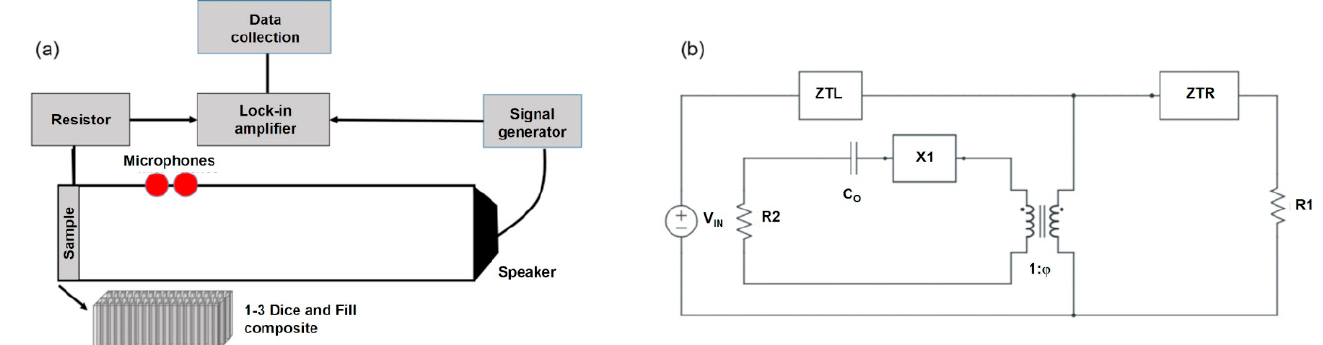
Figure 1. ( a ) Schematic of the experimental setup including the impedance tube and the 1–3 dice and fill composite. ( b ) KLM equivalent circuit for the present acoustic energy harvesting setup. ZTL and ZTR are the impedance values for the left and right acoustic ports, respectively.